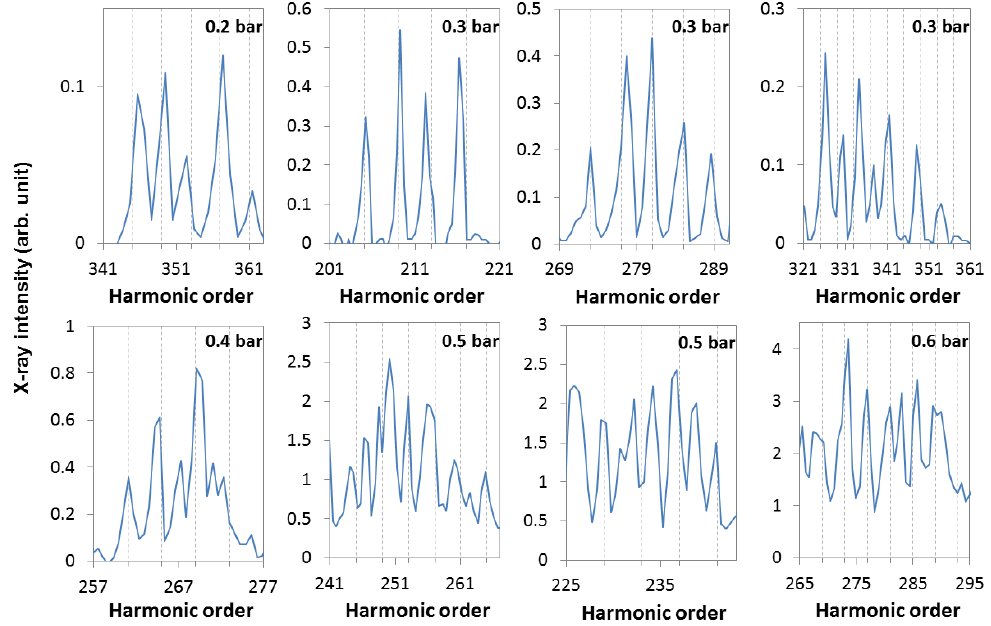
Figure 7. The recorded high harmonic spectra for different backing pressure settings exhibit an unexpected harmonic line structure. Only every fourth harmonic line (positions indicated by grey dashed lines) appears in the spectra instead of the expected all odd